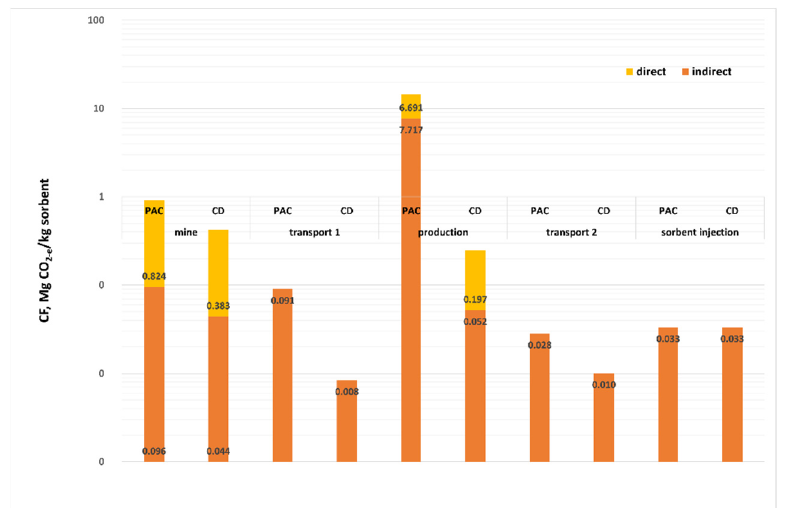
Figure 3. CF of the mercury removal process expressed per kg of sorbents over an assumed life cycle.